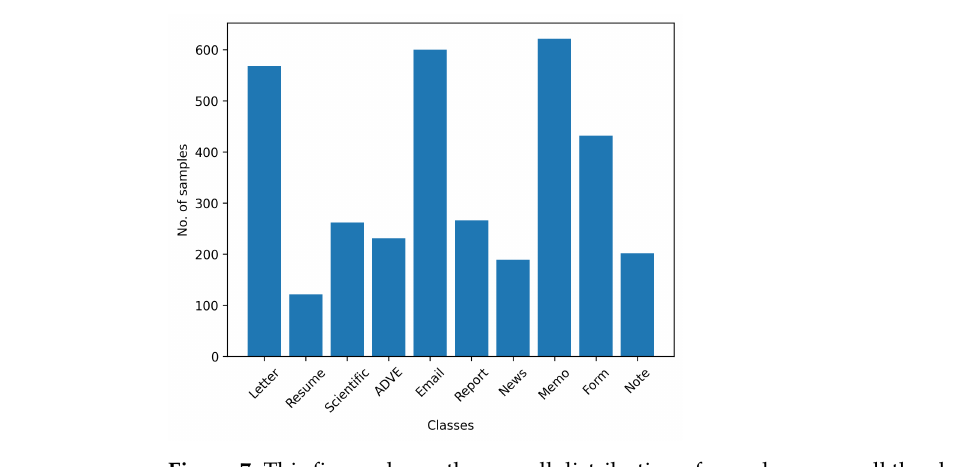
Figure 7. This figure shows the overall distribution of samples across all the classes in the Tobacco- 3482 dataset.